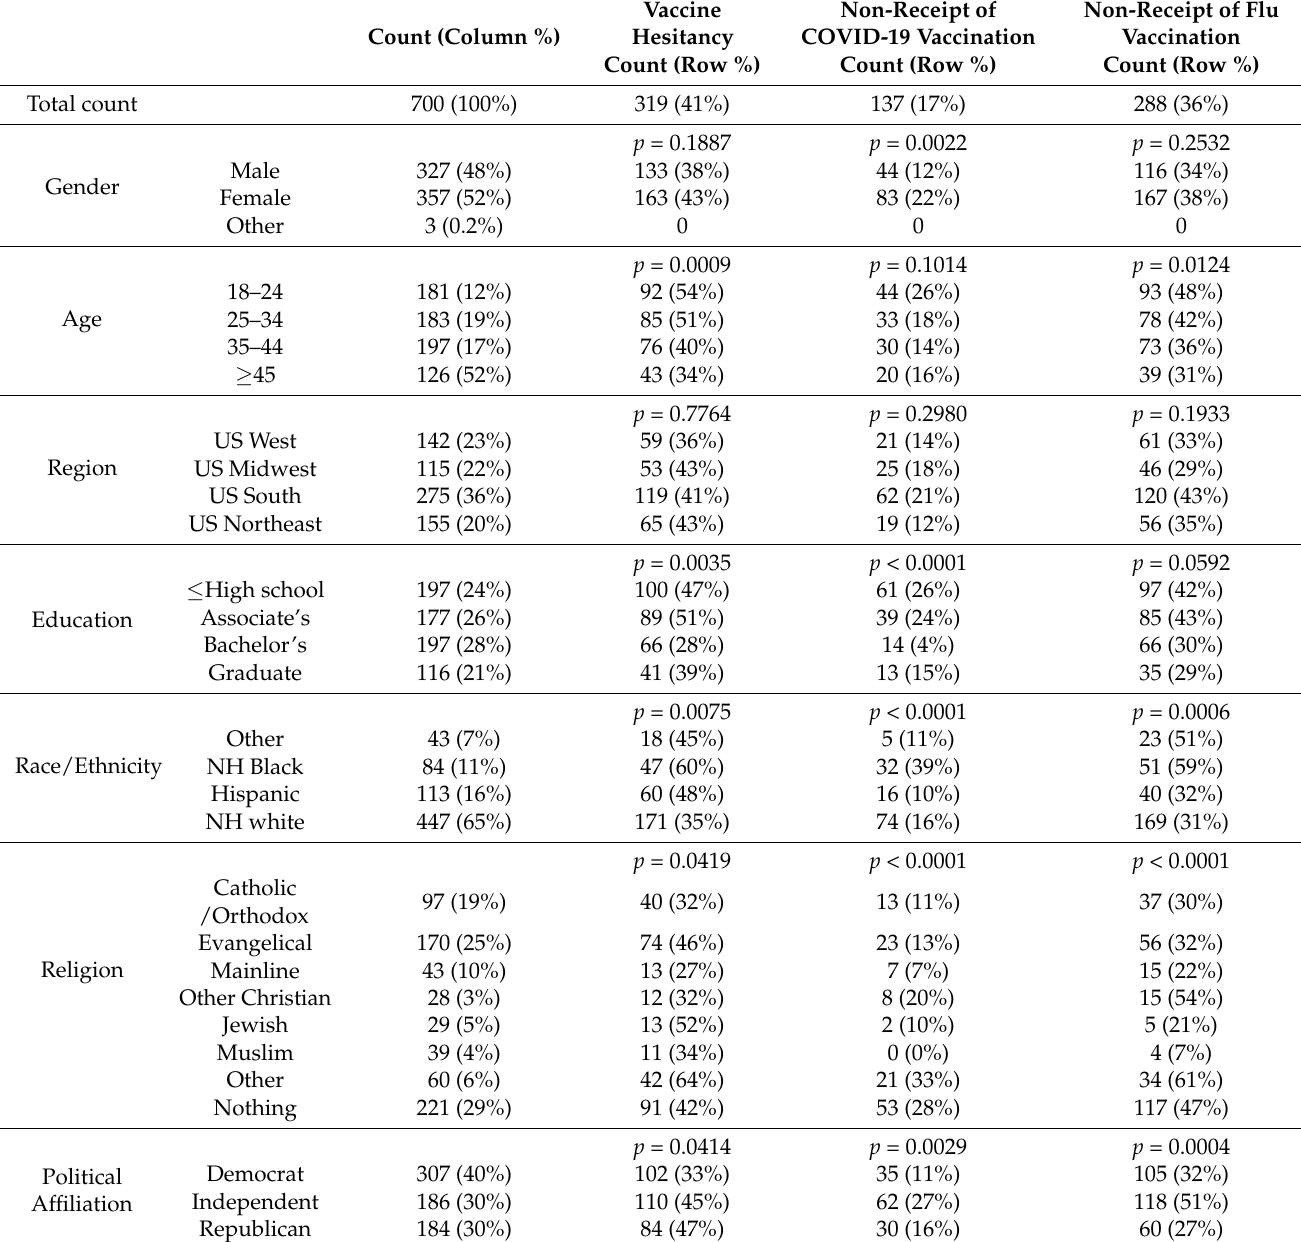
Table 1. The prevalence of vaccine hesitancy in general, the non-receipt of COVID-19 vaccination, and the non-receipt of flu vaccination by demographic characteristics; August